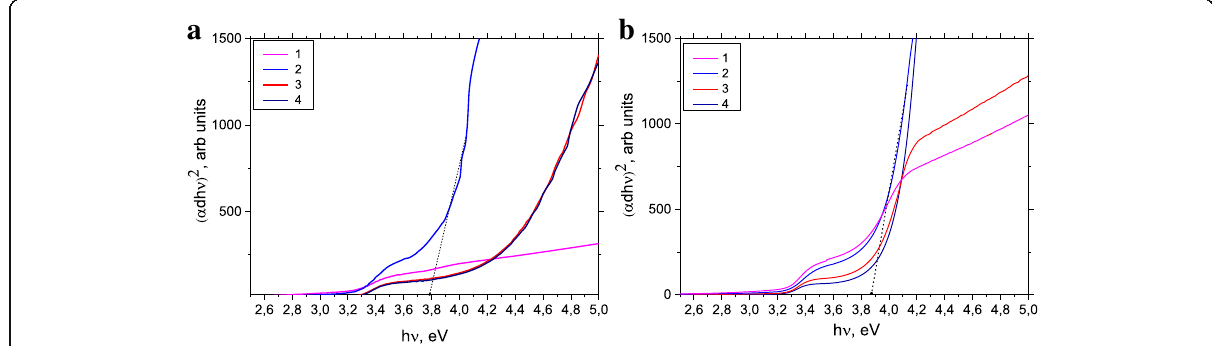
Fig. 6 Optical energy gap of the samples ( 1 PLD, 2 PLD-200A, 3 PLD-300, and 4 PLD-400) thin films ZnO as-growth ( a ) and annealed ( b )